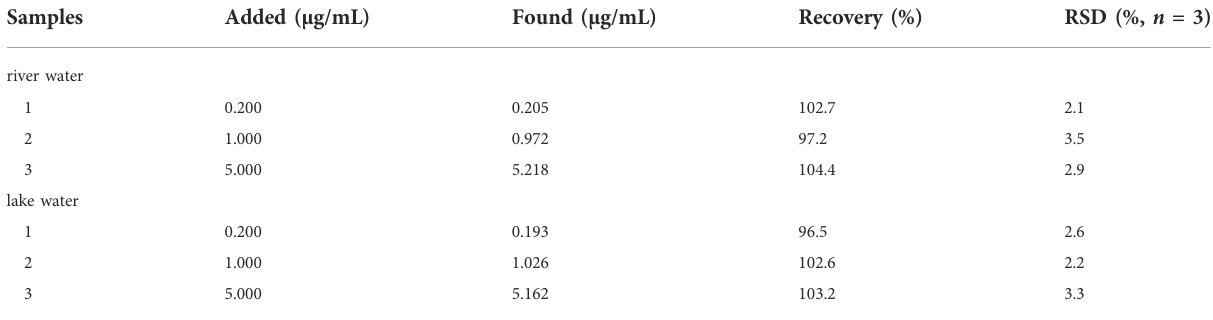
TABLE 1 Detection of glyphosate in river water and lake water samples.